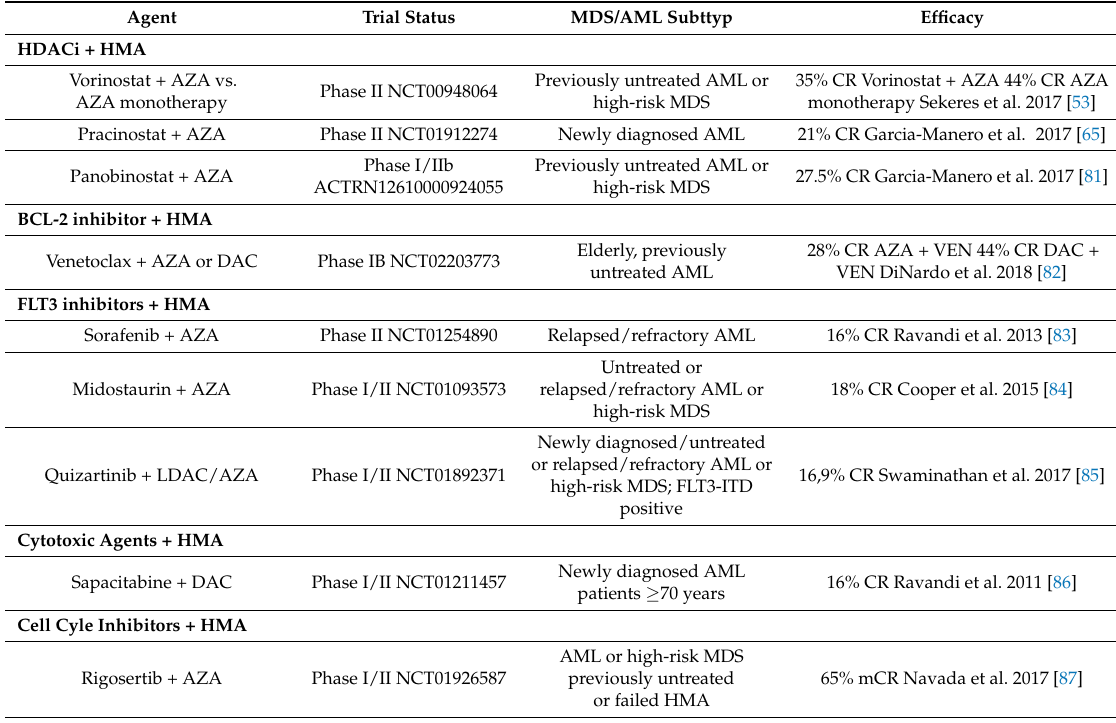
Table 1. Selected phase I/II clinical trials examining the combination of HMA with new upcoming treatment strategies currently under